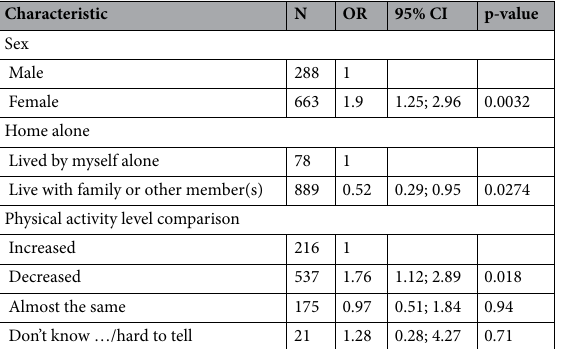
Table 1. Multiple logistic regression model for insomnia. OR odds ratio, CI confidence